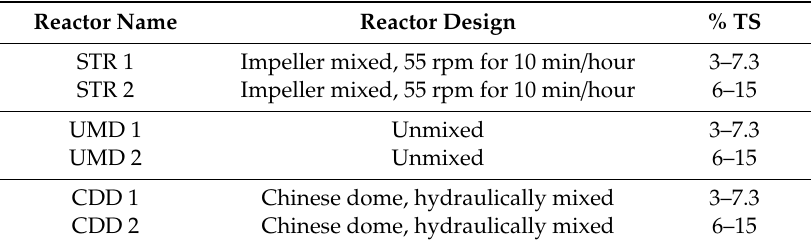
Figure 1. ( a ) Impeller mixed, ( b ) Unmixed, and ( c ) hydraulic mixed (Chinese dome) digesters. Table 1. Reactors set-up.